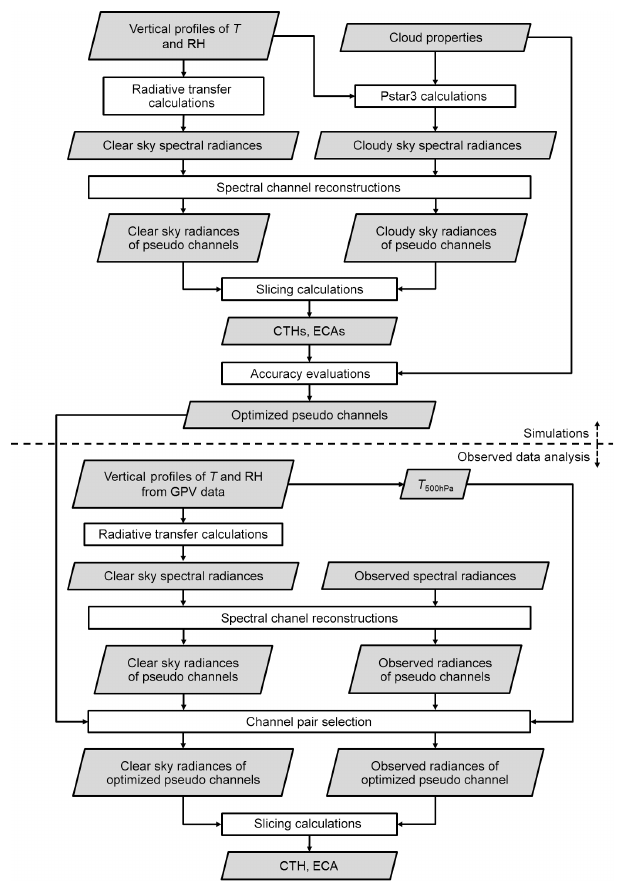
Figure 4. Flow chart showing simulation-based channel optimiza- tions and observed data analysis. White boxes are processes. The gray parallelograms are